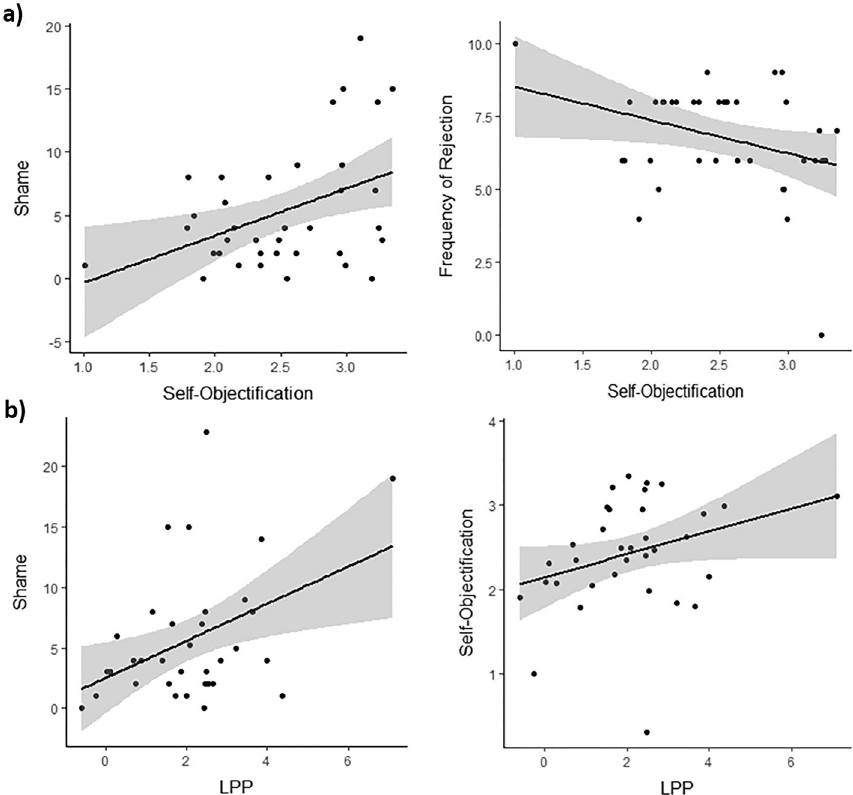
Figure 4. Results of correlational analyses. ( a ) Correlation between the level of self-objectification and the shame emotion, on the left, and the frequency of rejection, on the right; ( b ) correlation between the amplitude of the LPP and the shame emotion, on the left, and the level of self-objectification, on the